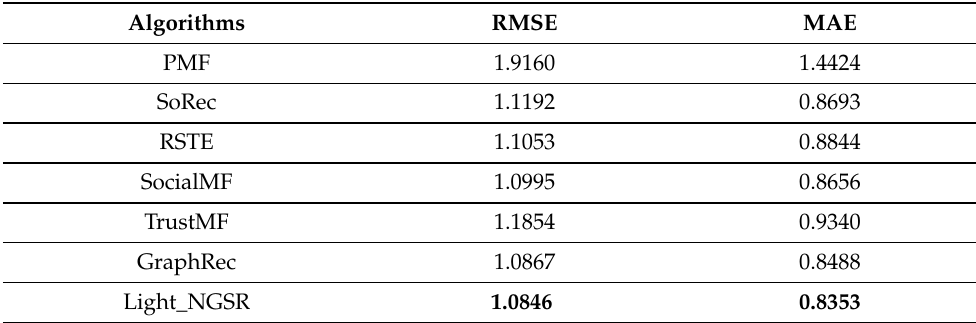
Table 4. Performance comparison on